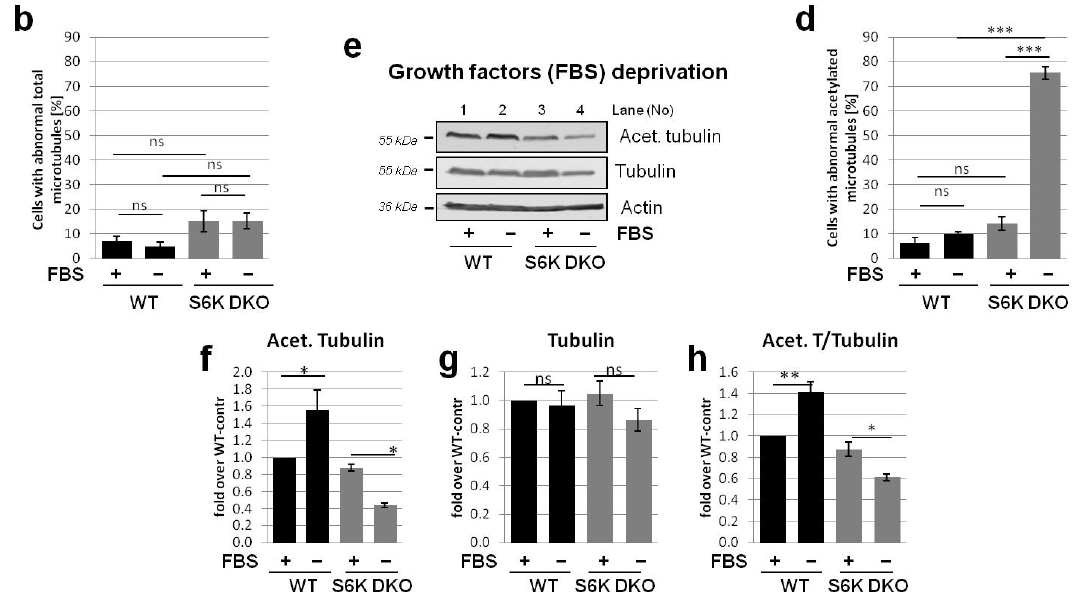
Figure 5. Lack of S6K affects the acetylated but not the total microtubule network in cells deprived of growth factors. Total ( a,b ) and acetylated microtubule network ( c,d ) was investigated by immunofluorescent staining of total α-tubulin ( a ) or acetylated tubulin ( b ), respectively, in WT and S6K DKO (DKO) MEF growing in a complete medium (control; +FBS) or deprived of growth factors (−FBS) for 16 h. The cells were stained using mouse antibodies against α-tubulin ( a ) or acetylated tubulin (Lys40) ( b ), followed by staining with goat anti-mouse–TRITC conjugates. DNA was stained with DAPI (blue). The indicated sections of original images are enlarged (middle panels), and for clarity, deconvoluted and transformed into inverted grey scale (bottom panels). Representative images of cells analyzed in at least 10 random fields per experiment are shown. Scale bar = 25 µ m. Approximately 100 cells per sample were counted in three independent replicates. The percentage of cells with a diffused, depolymerized (abnormal) microtubule ( b ) and acetylated microtubule ( d ) network was counted and graphed (mean ± SEM). Statistical significance was determined by one-way ANOVA followed by Bonferroni’s multiple comparison test: ** p < 0.01, *** p < 0.001; ns, not significant. ( e ) Acetylated tubulin and total α -tubulin levels were evaluated by western blotting in WT and S6K DKO MEF grown in a complete medium (control; +FBS) or a medium deprived of growth factors ( − FBS) for 16 h. The blots were re-probed with anti- β -actin antibodies to ensure equal protein loading. Densitometric data of acetylated tubulin ( f ) and tubulin ( g ) levels, corrected for loading control, as well as acetylated tubulin to total tubulin ratio ( h ) are presented as a fold-change from the reference, the control WT MEF ( lane 1 ). The experiment was performed in three independent replicates. The data are shown as the mean ± SEM. The statistical significance of differences was determined by one-way ANOVA followed by Bonferroni’s multiple comparison test: * p < 0.05, ** p < 0.01, *** p < 0.001; ns, not